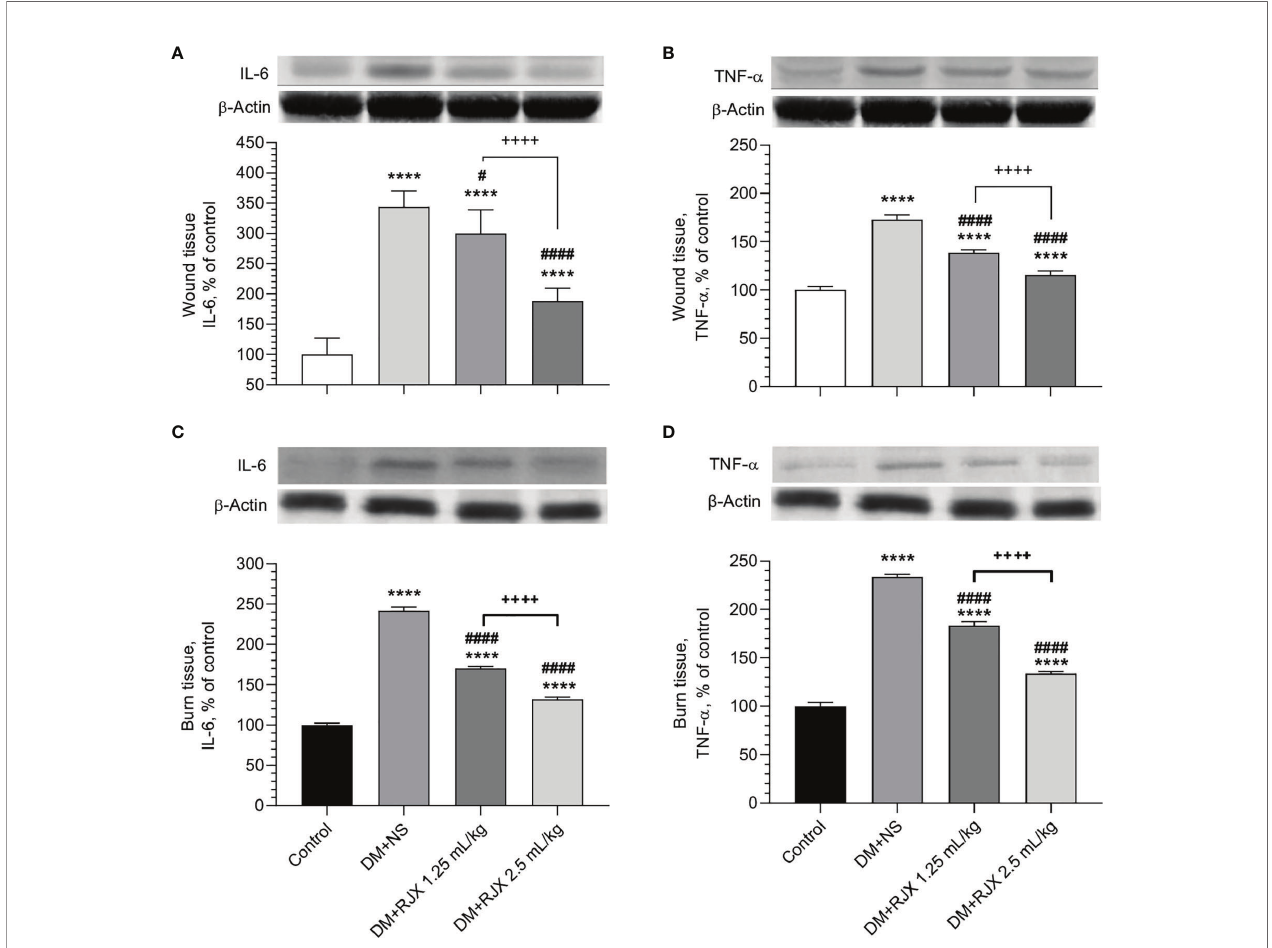
FIGURE 6 | The Effects of Rejuveinix (RJX) on Interleukin-6 (IL-6, A ) and Tumor Necrosis Factor- a (TNF- a , B ) in Diabetic Wound Healing (A, B) or Burn Wounds (C, D) Induced Diabetic Rats. Groups of 20 Wistar albino rats were treated with i.p injections of RJX (1.25 mL/kg and/or 2.5 mL/kg), or vehicle (NS). Except for untreated control rats (Control), each rat was fed a high-fat diet (HFD) for 4 weeks and injected a single dose of streptozotocin (STZ, 45 mg/kg i.p.) to induce diabetes (DM). At the end of 4 weeks, an experimental wound with a diameter of 5 mm was formed in all rats. On day 21, fi ve rats in each group were selected and skin tissues were removed and processed for Western blot analyses. The depicted bars represent the relative levels for IL-6 and TNF-a in skin wound or burn tissues of NS or RJX-treated diabetic rats in comparison to the levels for IL-6 and TNF-a in tissue specimens from healthy control rats (control). Results are expressed as percent of control with the expression level in the skin tissue samples from untreated healthy control rats taken as 100% for comparisons. Each bar represents the mean and standard deviation. Immunoblotting with an anti-actin antibody was used to ensure equal protein loading. ANOVA and Tukey ’ s post-hoc test were used for comparing the results among different treatment groups. Statistical signi fi cance between groups is shown by ****p<0.0001 as compared to control group, and # p<0.05; #### p<0.0001 as compared to DM+NS group, and ++++ p <0.0001 pairwise comparisons between the